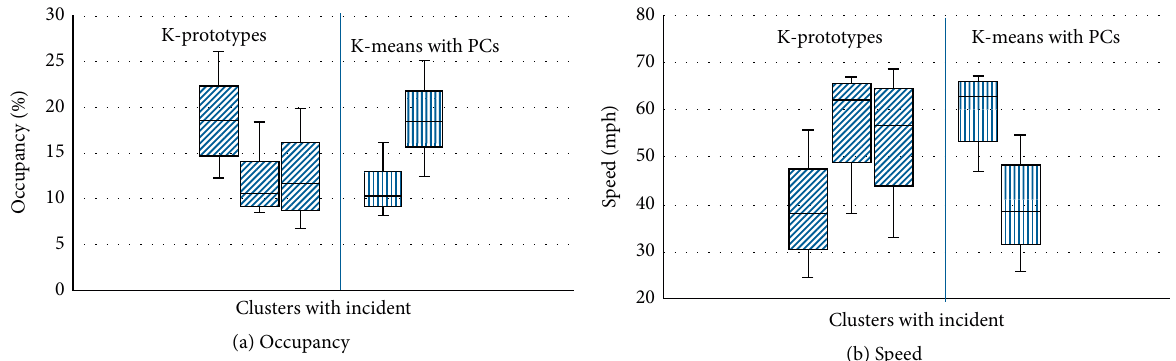
Figure 11: Variation of occupancy and speed within the clusters identified by the clustering methods for incident days.